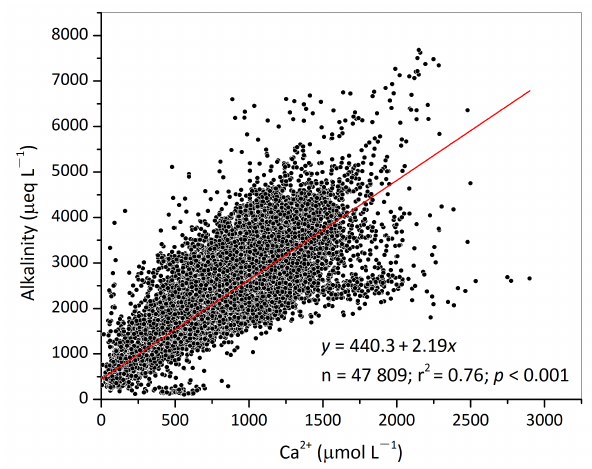
Figure 7. Strong correlation between chemical weathering, using Ca 2 + as a proxy, and alkalinity.